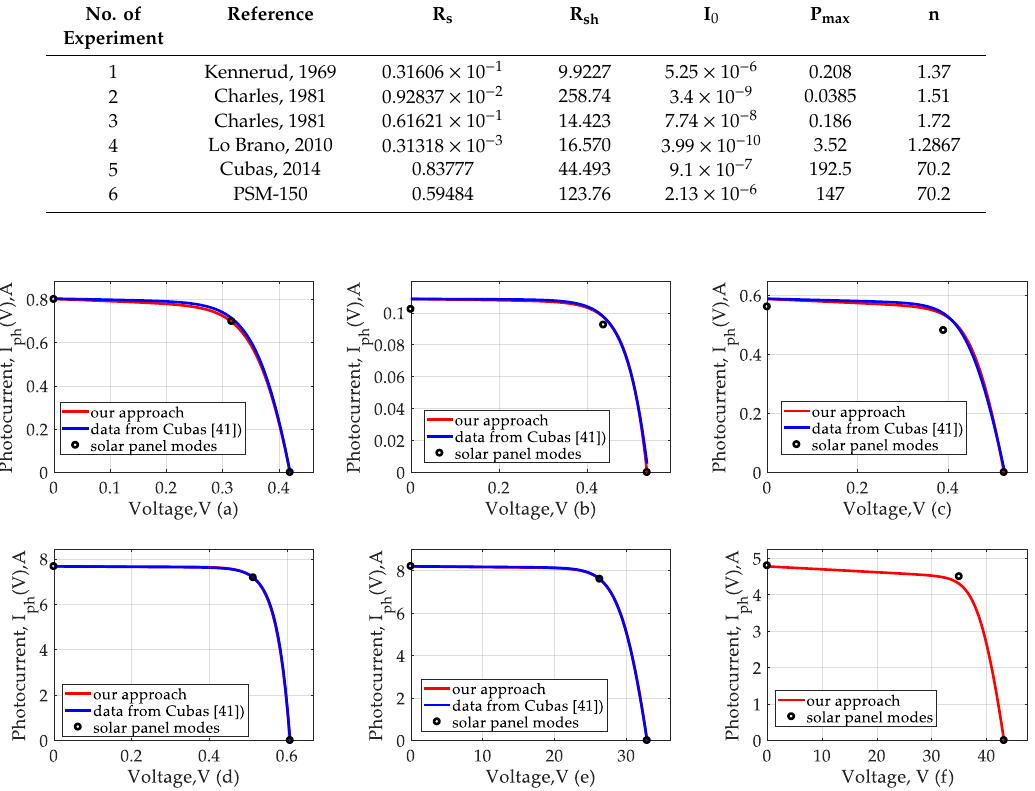
Table 4. 1-Diode / 2-resistors circuit model parameter values from di ff erent solar cells (with data Table 4. 1-Diode/2-resistors circuit model parameter values from different solar cells (with data from from [41]). [41] ) .